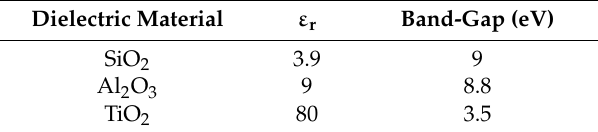
Table 1. Values of the relative permittivity, ε r , and band gap of the different materials employed as dielectric layers for the supercapacitors. The given values are those collected from the work of